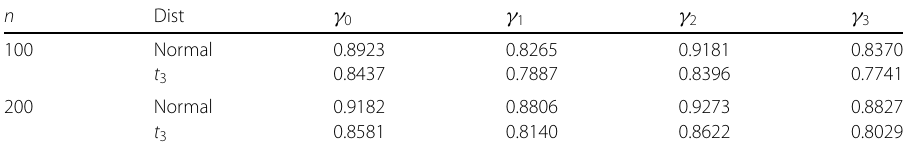
Table 2 Coverage probabilities of confidence regions when the nominal level is